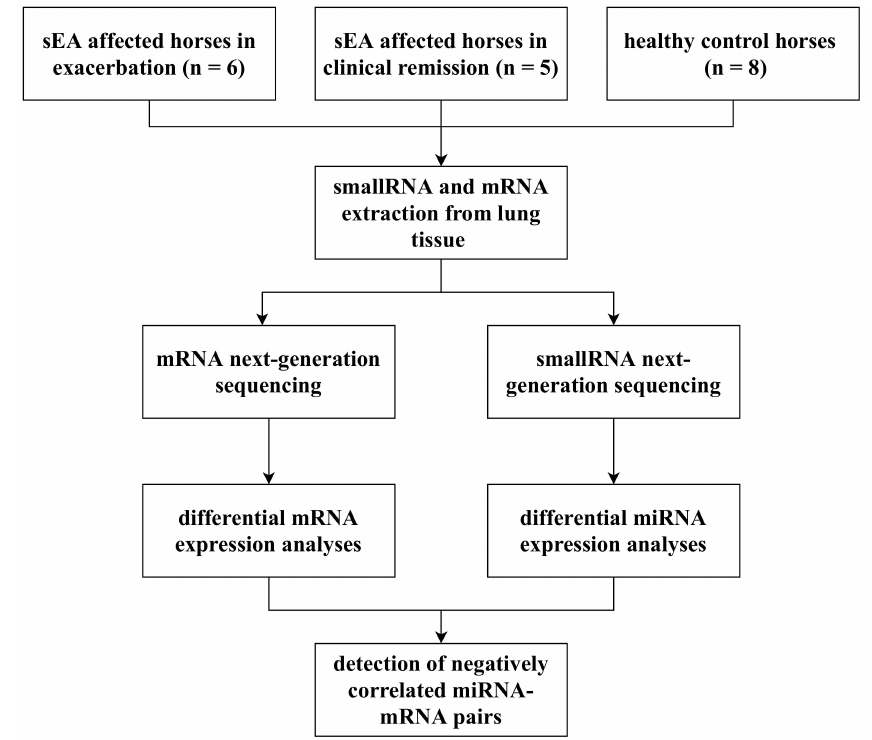
Figure 1. A schematic illustration of the workflow of this study. sEA, severe equine